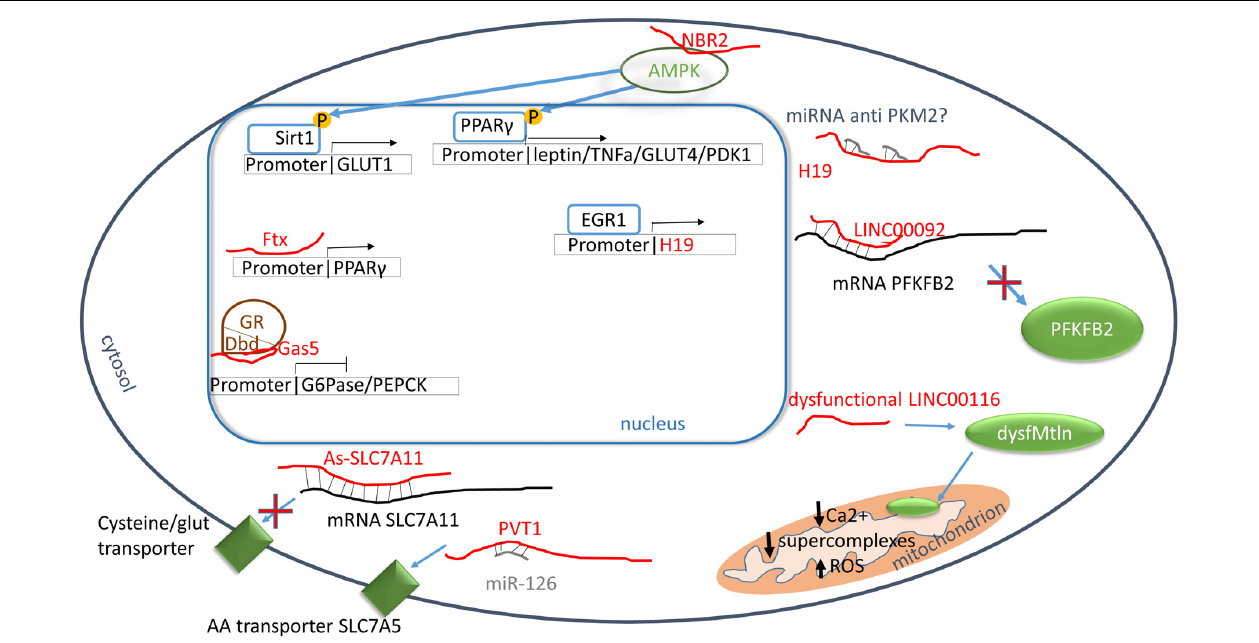
FIGURE 1 | Carbohydrate and protein metabolisms. Red: lncRNAs; green: proteins; blue: transcriptor factors; brown: nuclear receptors. PPAR γ promoter binds directly Ftx increasing the transcription. PPAR γ is phosphorylated through AMPK pathway and it enhances the transcription of leptin, tumor necrosis factor α (TNF α ), glucose channel 4 (GLUT4) and pyruvate dehydrogenase kinase 1 (PDK1). In turn, AMPK activity is enhanced by the binding to NBR2. H19 influences the transcription of pyruvate kinase M2 probably by the inhibition of PKM2 miRNAs, however, more studies are necessary to elucidate the molecular mechanism. The glucocorticoid receptor (GR) is blocked by Gas5 which interacts to GR DNA binding domain resulting in an inhibition of 6-phosphoglucanase (G6Pase) and phosphoenolpyruvate carboxykinase (PFKFB2). LINC00092 stabilizes phosphofructo-2-kinase/fructose-2,6-phosphatase 2 (PFKFB2) mRNA allowing its synthesis. LINC00116 encodes the microprotein mitoregulin (Mtln) which acts into mitochondrial inner membrane increasing the formation of supercomplexes, calcium intake and reducing ROS formation. The alteration of LINC00116 generate dysfunctional of low levels of Mtln. As-SLC7A11 binds SLC7A11 mRNA inhibiting the translation of cysteine/glutamine transporter, meanwhile plasmacytoma variant translocation 1 (PVT1) enhance the synthesis of AA transporter through the binding of miR-126 which is a suppressor of SCL7A5